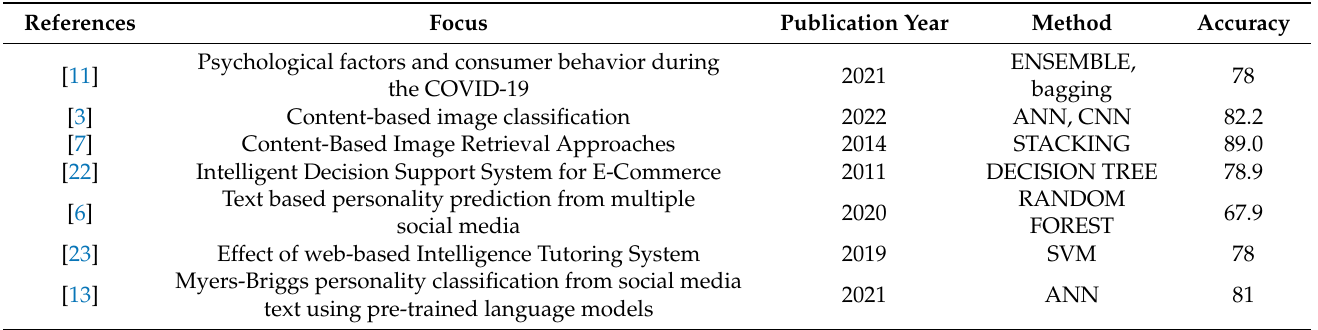
Table 1. State-of-the-art summary and